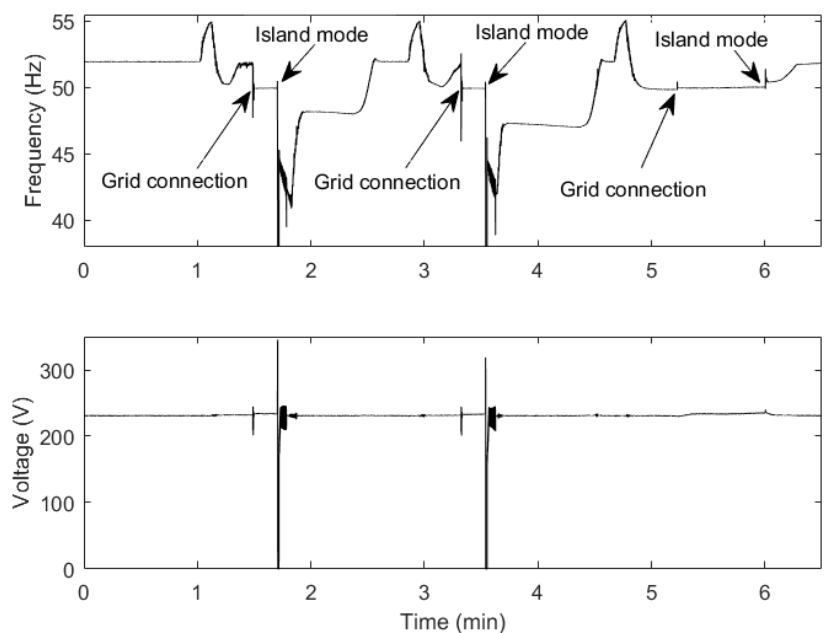
Figure 6. Enlarged view of the largest frequency variations from Figure 5 ( top ) and its corresponding voltage ( bottom ) for one phase. The scale is truncated at 38 Hz since the frequency drops towards 0 during the interruptions.